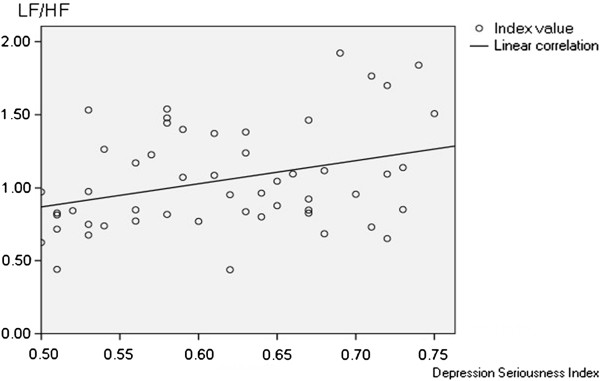
The correlation between Depressive severity index and LF/HF. Pearson relativity analysis shows a positive correlation between depressive severity index and LF/HF (P<.05, r = .335).